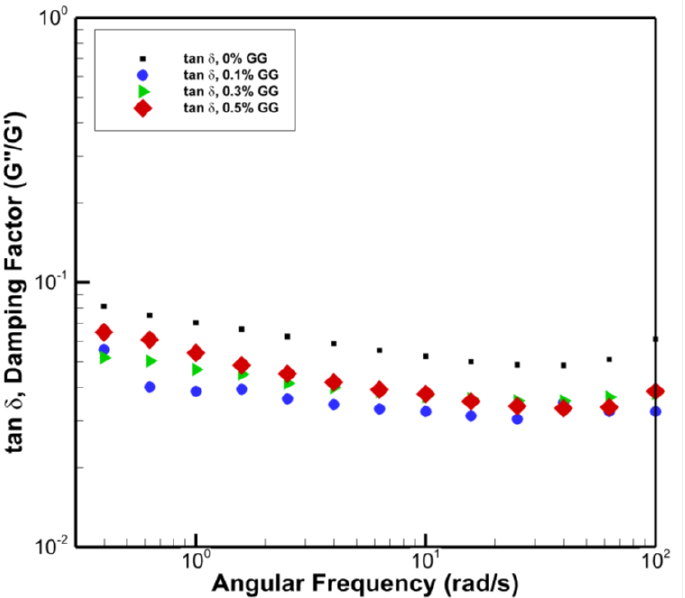
Figure 3. Damping factor (tanδ) versus angular frequency for pure PVA and PVA/GG composites with different concentrations.